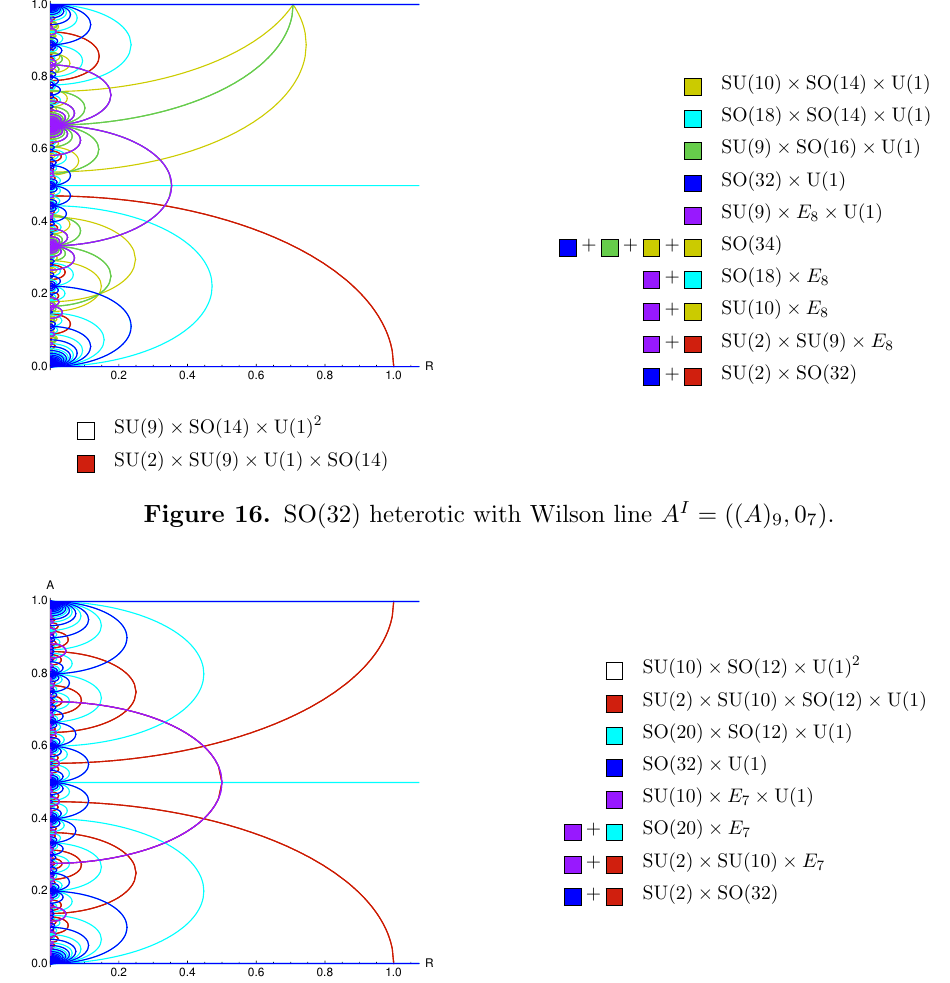
Figure 17. SO(32) heterotic with Wilson line A I = (( A ) 10 ; 0 6 ).